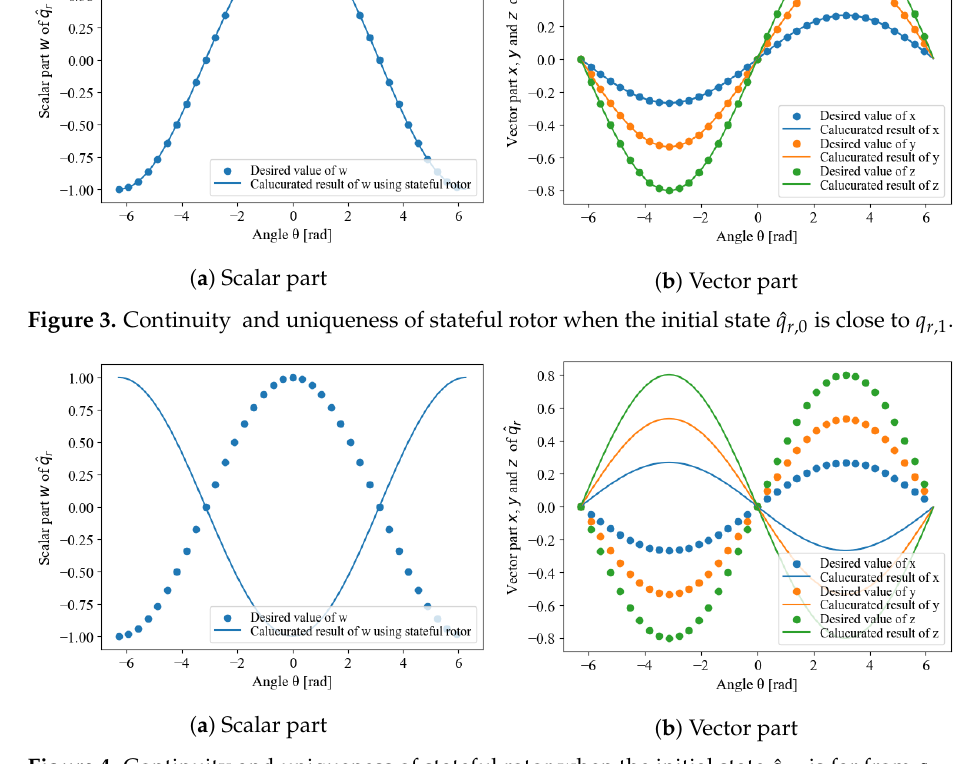
Figure 4. Continuity and uniqueness of stateful rotor when the initial state ˆ q r ,0 is far from q r ,1